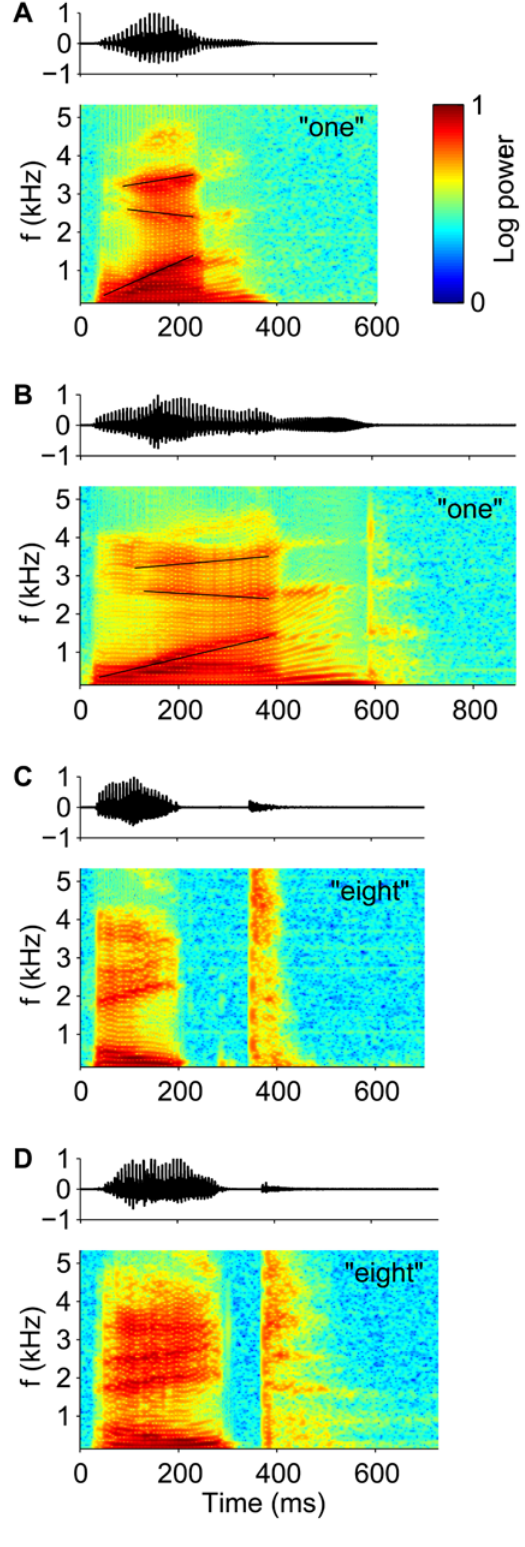
Figure 1. Time warp in natural speech. Sound pressure waveforms (upper panels, arbitrary units) and spectrograms (lower panels, color- code scaled between the minimum and maximum log power) of speech samples from the TI46 Word corpus [24], spoken by different male speakers. (A and B) Utterances of the word ‘‘one.’’ Thin black lines